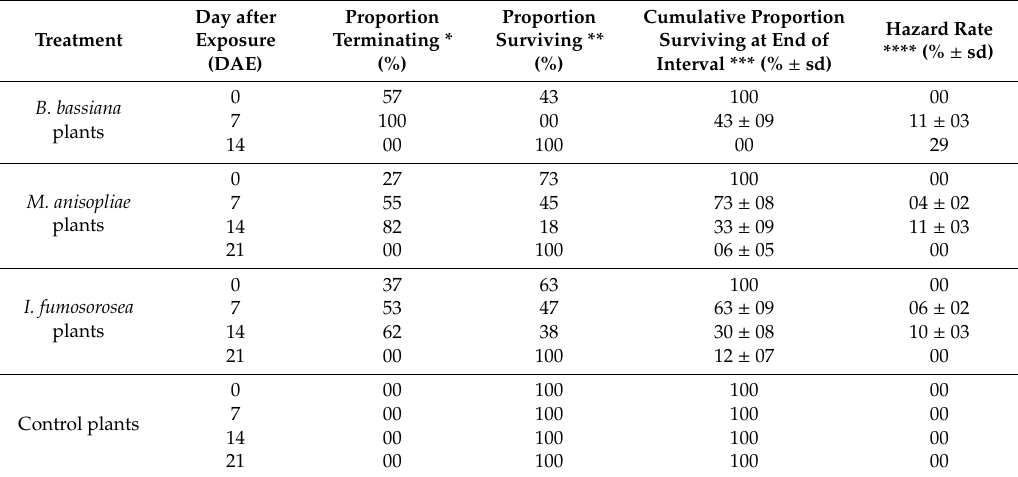
Table 1. Proportion terminating, proportion surviving, cumulative proportion surviving and hazard rate of endophytic colonized pepper plants on young apterous adults of the M. persicae aphid (Kaplan–Meier survival function, life table parameters).